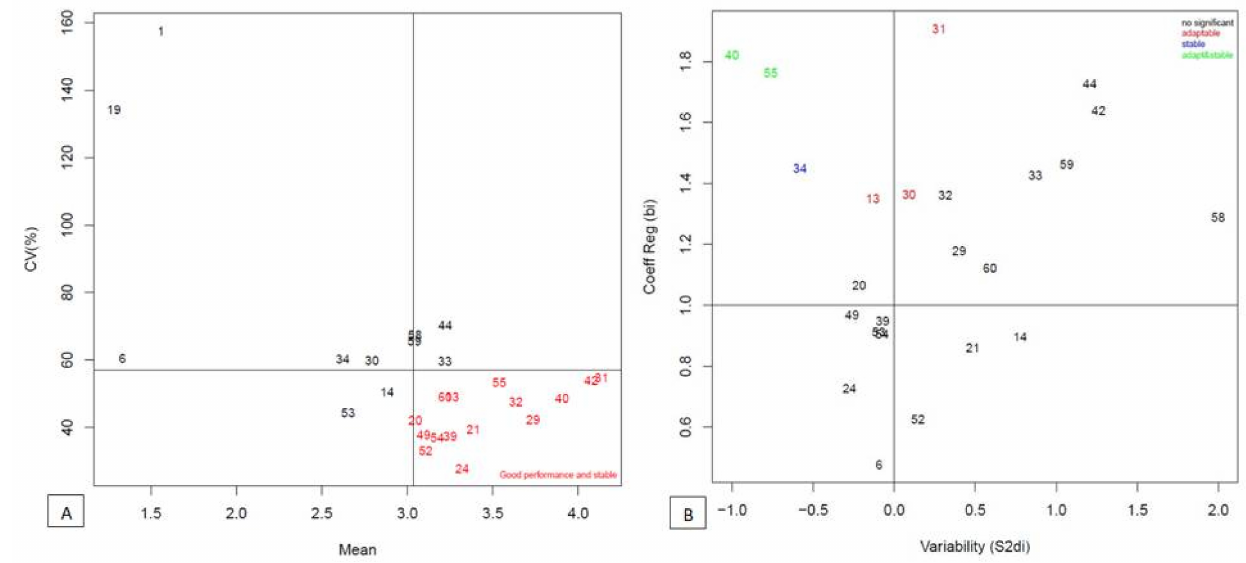
Figure 2. Covariance percentage and coefficient of regression biplots showing adaptation and stability of genotypes across environments. ( A ) A biplot showing covariance percentage (CV%) against mean grain yield performance of 26 maize genotypes evaluated across nine environments in Zimbabwe. ( B ) A graphical presentation of the Eberhart and Russel coefficient of regression (bi) vs. variability (S 2 di) of mean grain yield for 26 maize genotypes evaluated across nine environments in Zimbabwe. The numbers represent the genotypes evaluated and these correspond with the genotype codes in Table